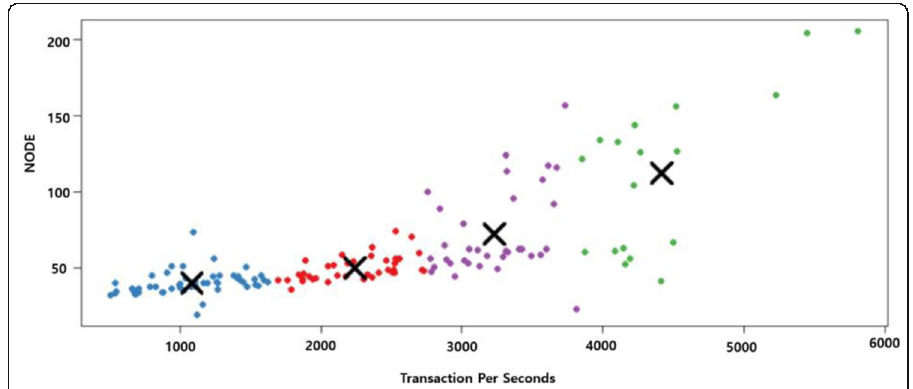
Fig. 15 K-means clustering for TPS